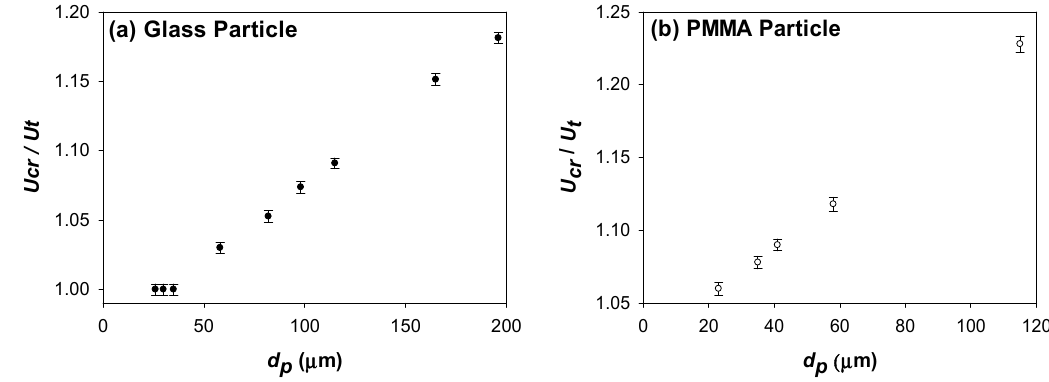
Figure 13. Normalised critical transition velocity as a function of particle size for ( a ) glass and ( b ) PMMA micro-particles with solid inventory in the range of 10–25%.